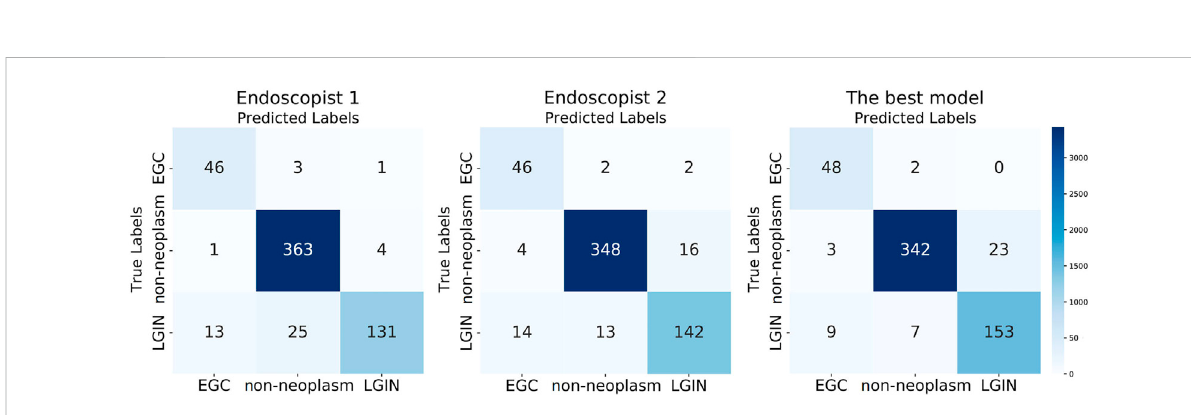
FIGURE 4 Three confusion matrixes for two endoscopists and the best model ’ s predictions, respectively.